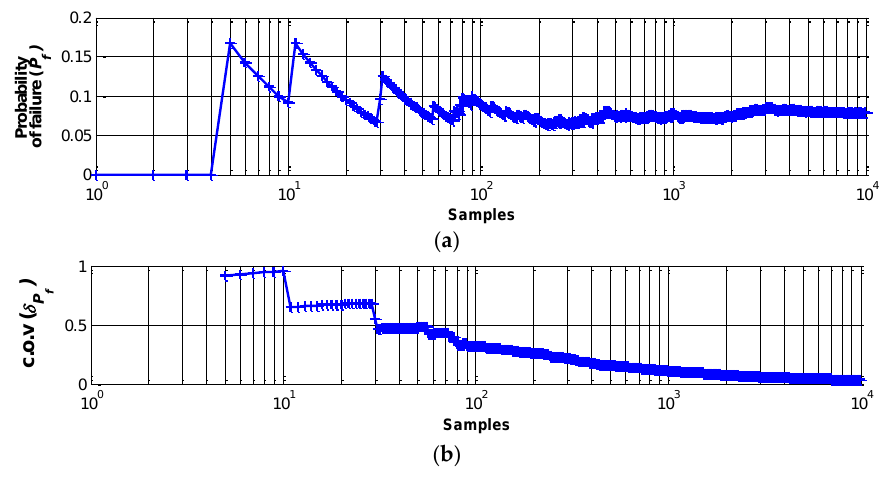
Figure 8. MCS results; ( a ) Probability of failure ( P f ); and ( b ) c.o.v. ( δ P